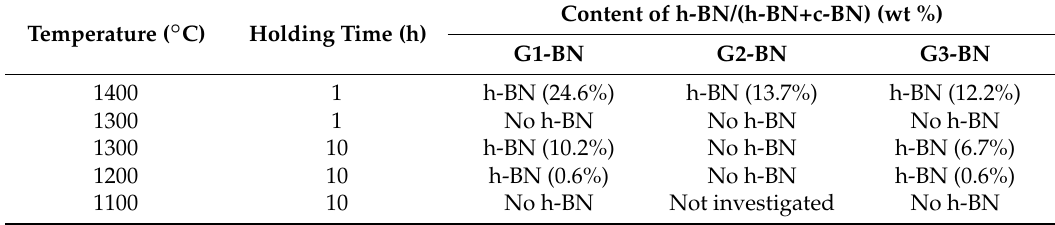
Table 3. Heat treatment conditions and results of analysis of h-BN formation based on microstructural analysis and XRD